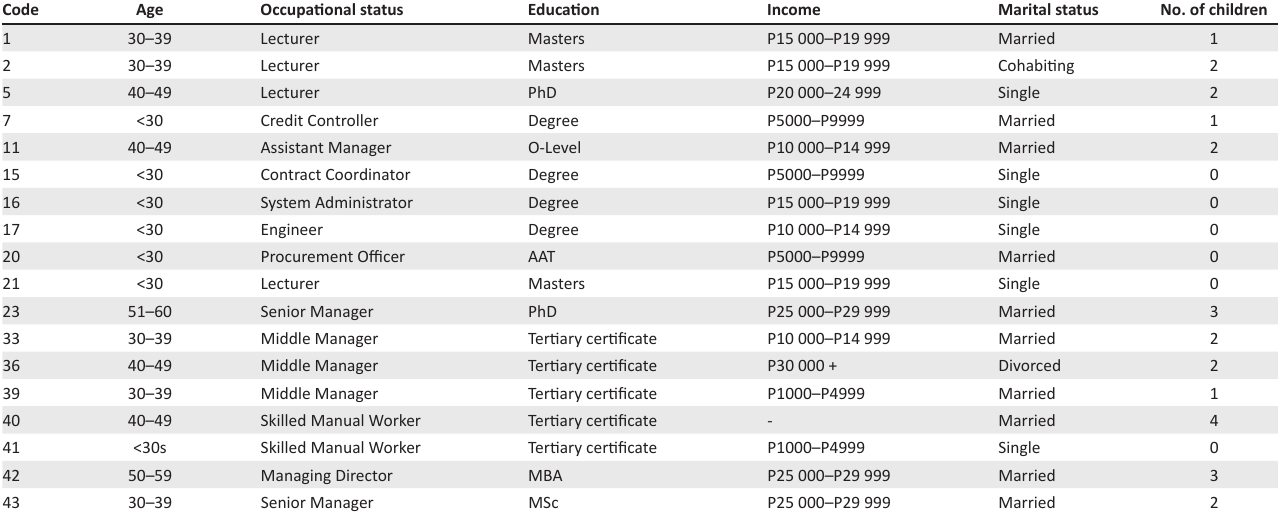
TABLE 1-A1: Profile of male savers.